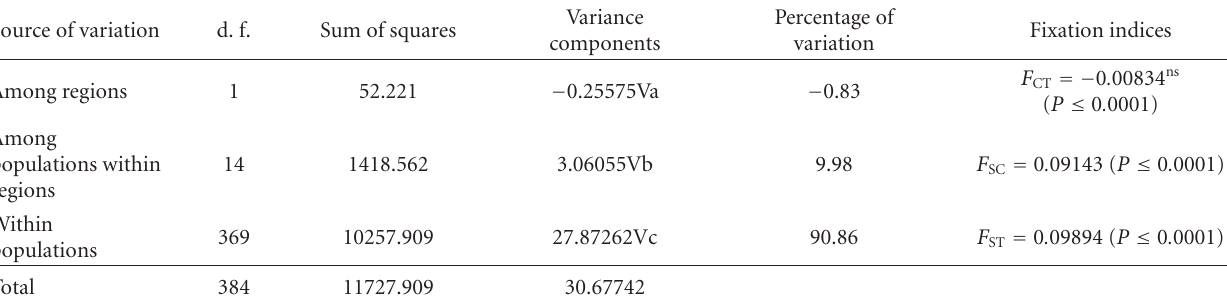
Table 4: AMOVA analysis comparing results of genetic variation from G. citricarpa sampled in four sweet orange varieties in same and in di ff erent plants in two geographic places.